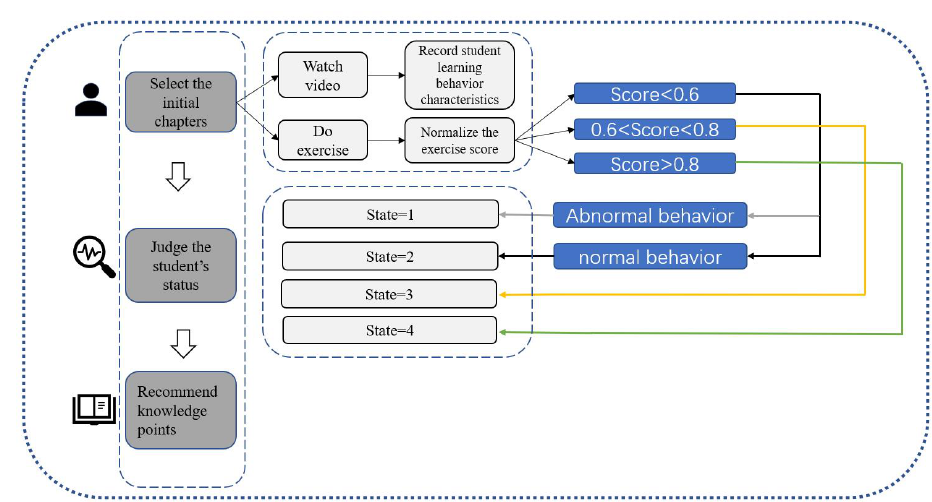
Figure 2. Flow chart of student status judgment. Abnormal behaviors include fast-forwarding or skipping when watching a video, and normal behaviors entail no such